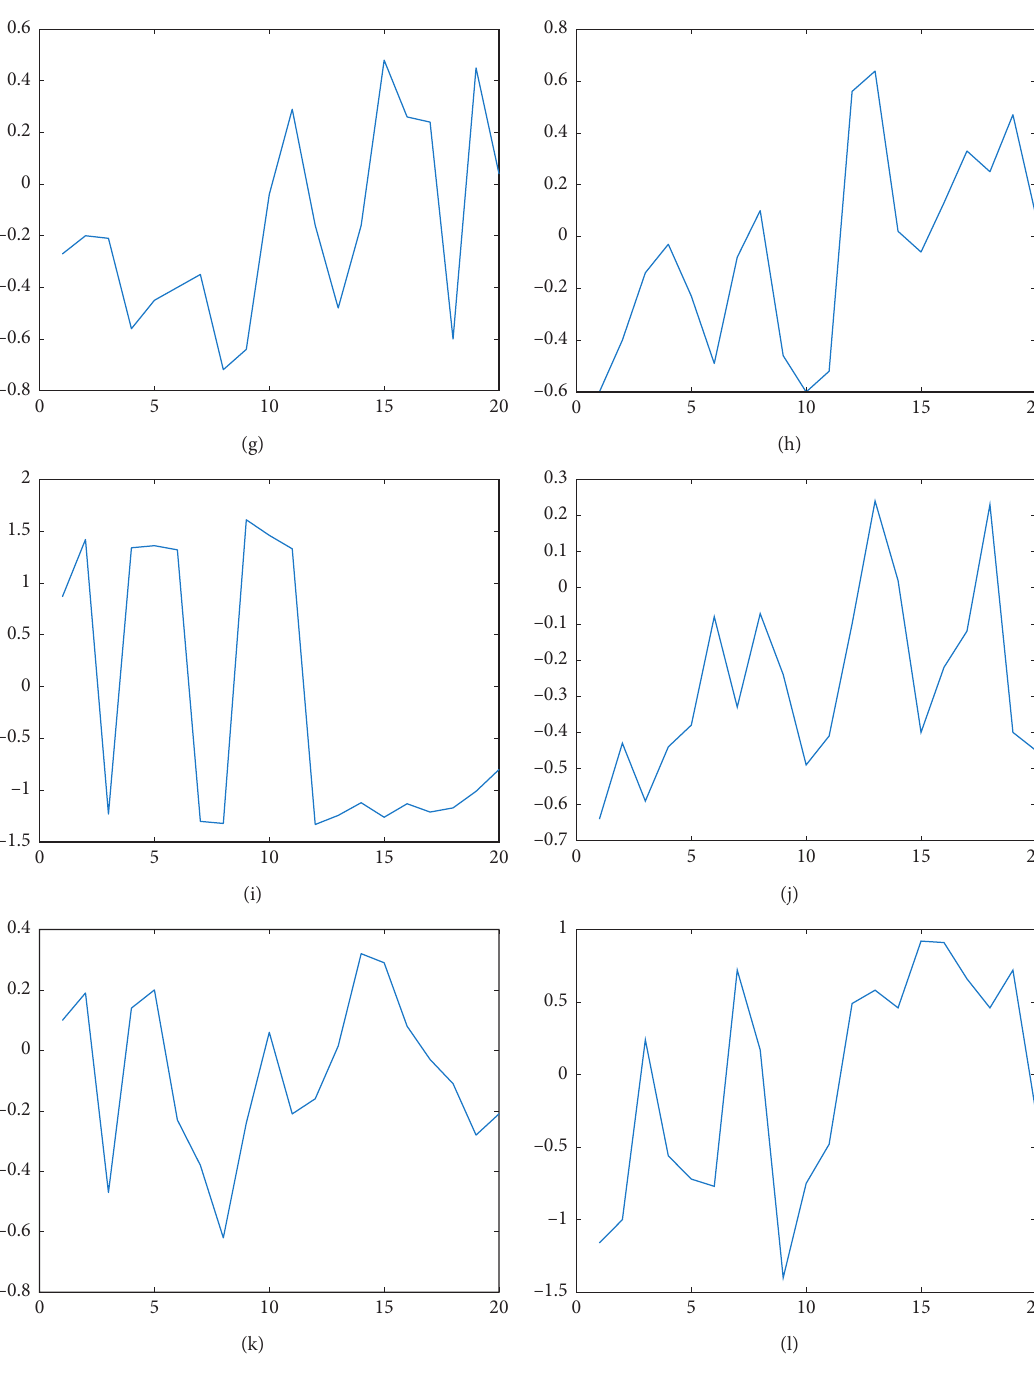
Figure 9: Dynamic factor analysis of pricing efficiency for IC, IF, and IH contracts: (a) IC1704; (b) IC1705; (c) IC1706; (d) IC1709; (e) IF1704; (f) IF1705; (g) IF1706; (h) IF1709; (i) IH1704; (j) IH1705; (k) IH1706; (l)